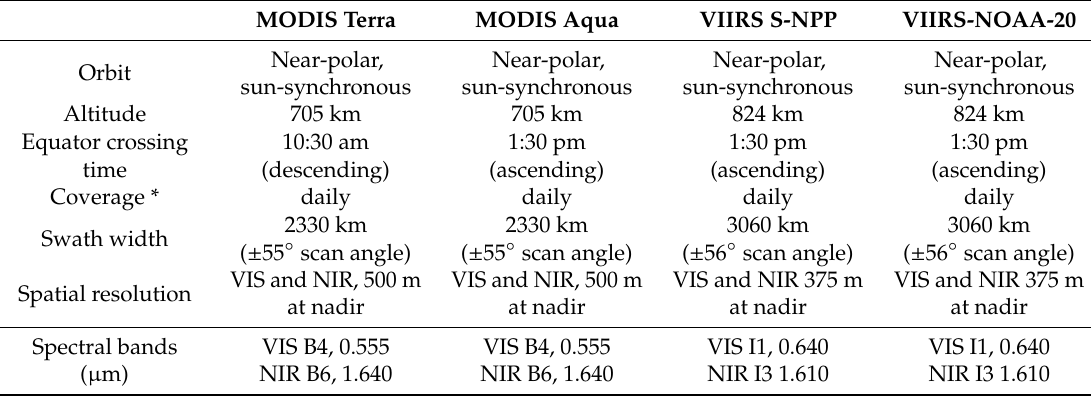
Table 1. Satellite and sensor characteristics relevant for calculation of the